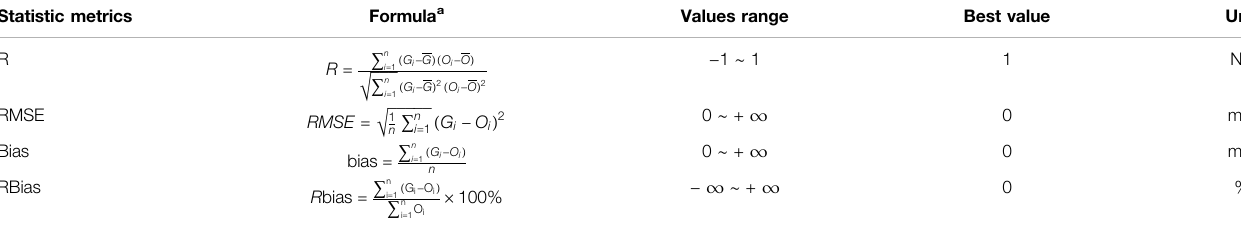
TABLE 3 | Summary of statistic metrics used to evaluate the gridded precipitation products.